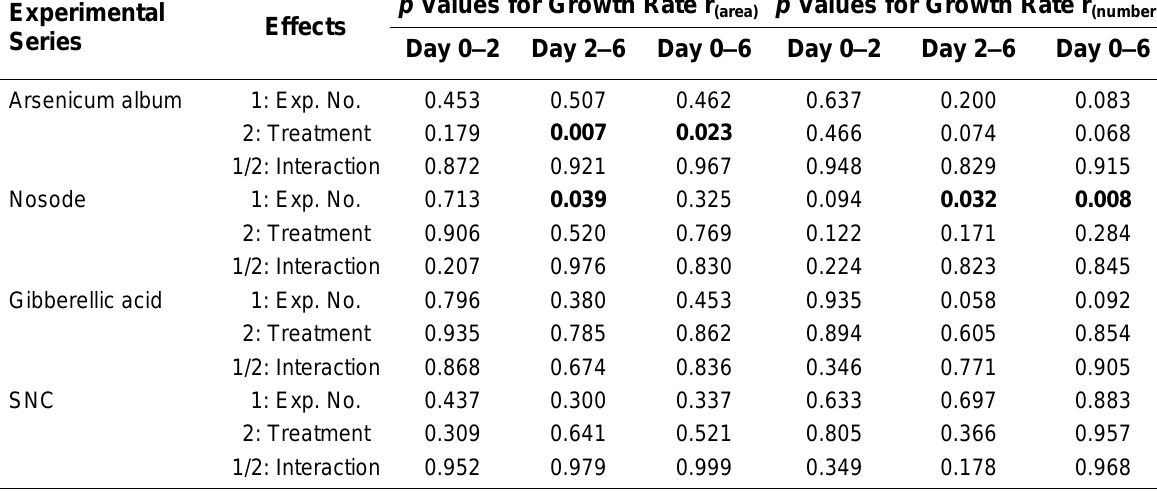
ANOVA Analysis of the Four Main Experimental Series Regarding Single Potency